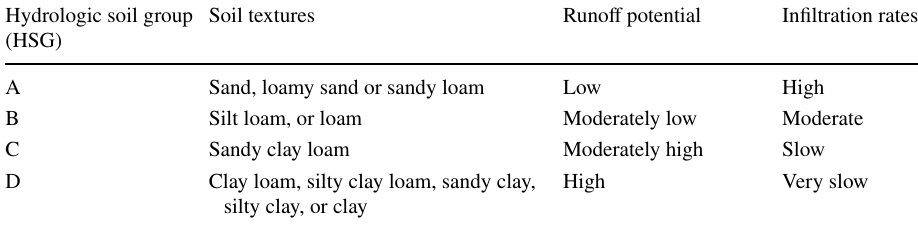
Table 2 USDA-Soil conservation service (SCS) classification system,